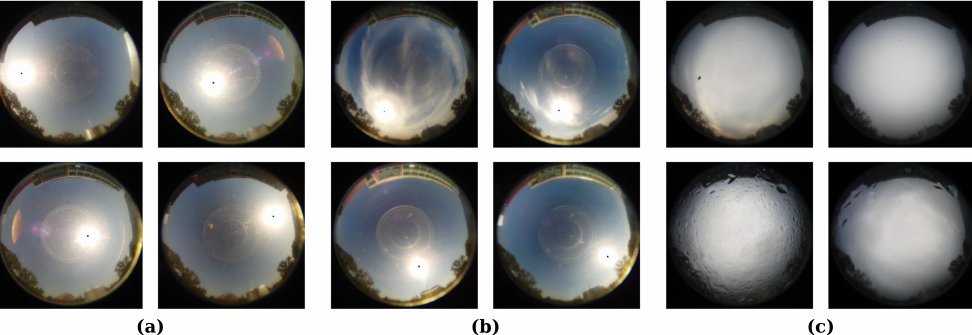
Figure 3. Sky images corresponding to the markers on the daily irradiance plot, from left to right and top to bottom, for the days ( a ) 7 June 2014, ( b ) 3 November 2014, and ( c ) 24 December 2014.